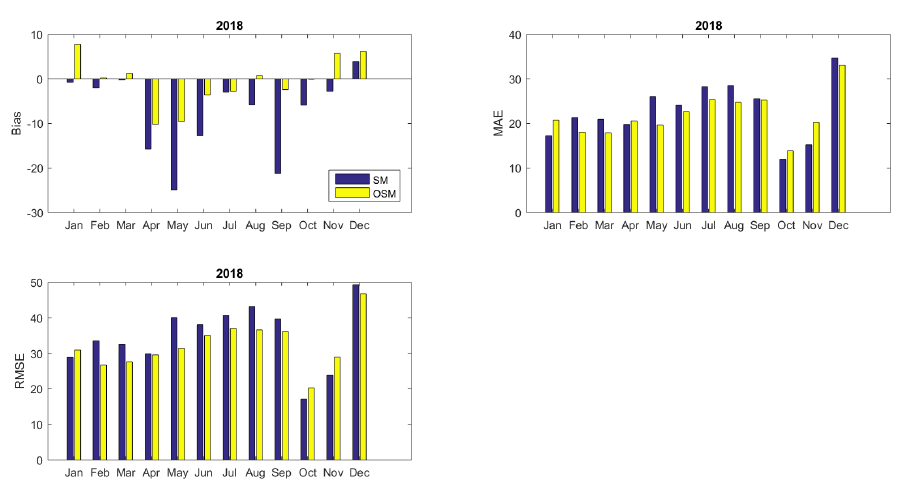
Figure 9. Statistical error indices for the energy prediction through the simulation model (SM) and the optimized simulation model (OSM) for the year 2018 (per